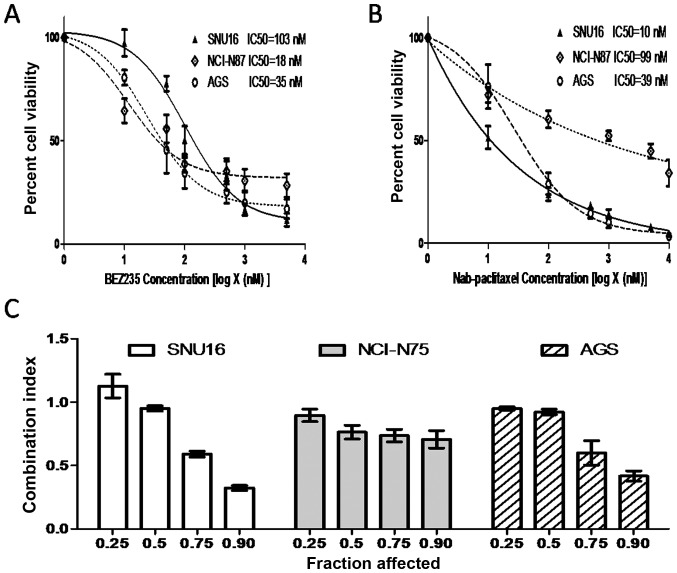
Additive effects of BEZ235 and nab-paclitaxel on cell proliferation in vitro. Human gastric cancer cells SNU16, NCI-N87 and AGS were plated on 96-well plates and treated with BEZ235 (A), nab-paclitaxel (B) and a combination of the two at a fixed ratio (C). After 72 h, 10 μl WST-1 reagent was added in each well and incubated for 2 additional hours. The absorbance at 450 nm was measured using a microplate reader. The resulting number of viable cells was calculated by measuring absorbance of color produced in each well. The antiproliferative effect was then assessed and median effect analysis (CalcuSyn software) was used to evaluate the combination effect. The combination index (CI) is plotted as a function of the fraction of cells affected by the cytotoxic effect. CI>1.1 indicates antagonism, CI=0.9–1.1 indicates additivity and CI<0.9 indicates synergism. Data are the mean ± SD of triplicate determinations.